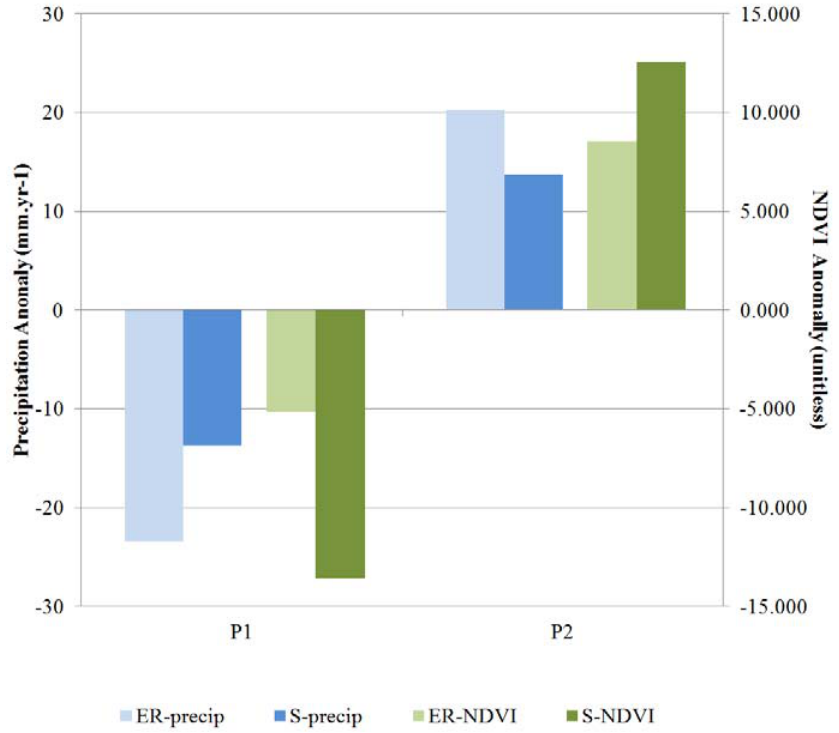
Figure 3. Changes in rainy season precipitation and growing season NDVI from P1 to P2 (see text for details). Changes in NDVI values were scaled by 1,000 for plotting purposes. Prefix ER is for Errachidia and S for